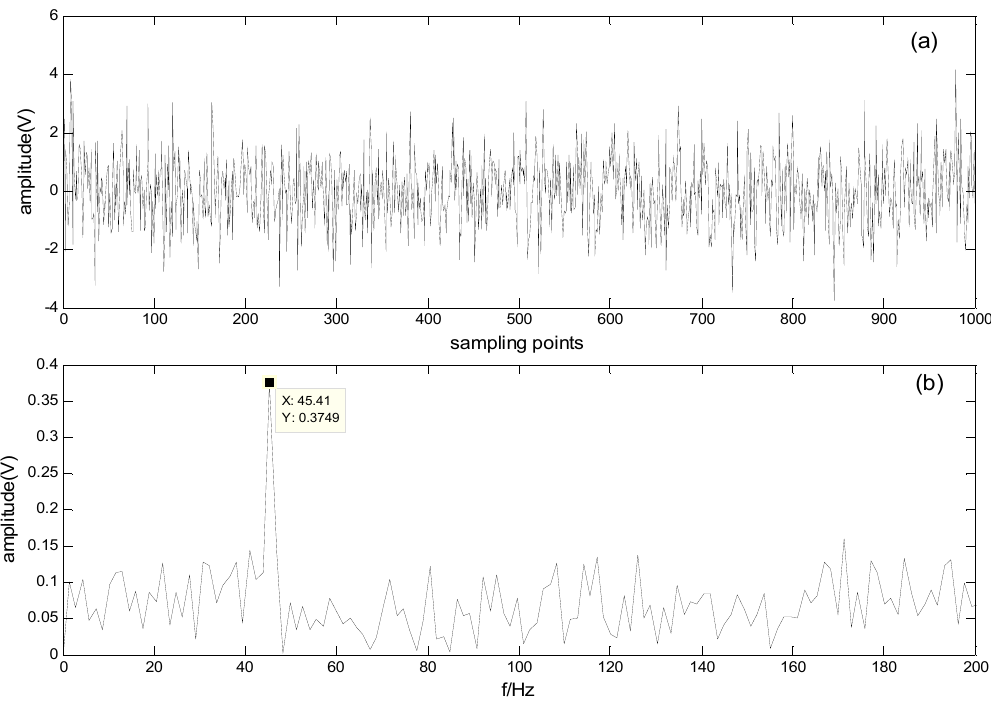
Figure 3. Simulated signal and its spectrum: ( a ) Waveform of the simulated signal; ( b ) Spectrum of the simulated signal.